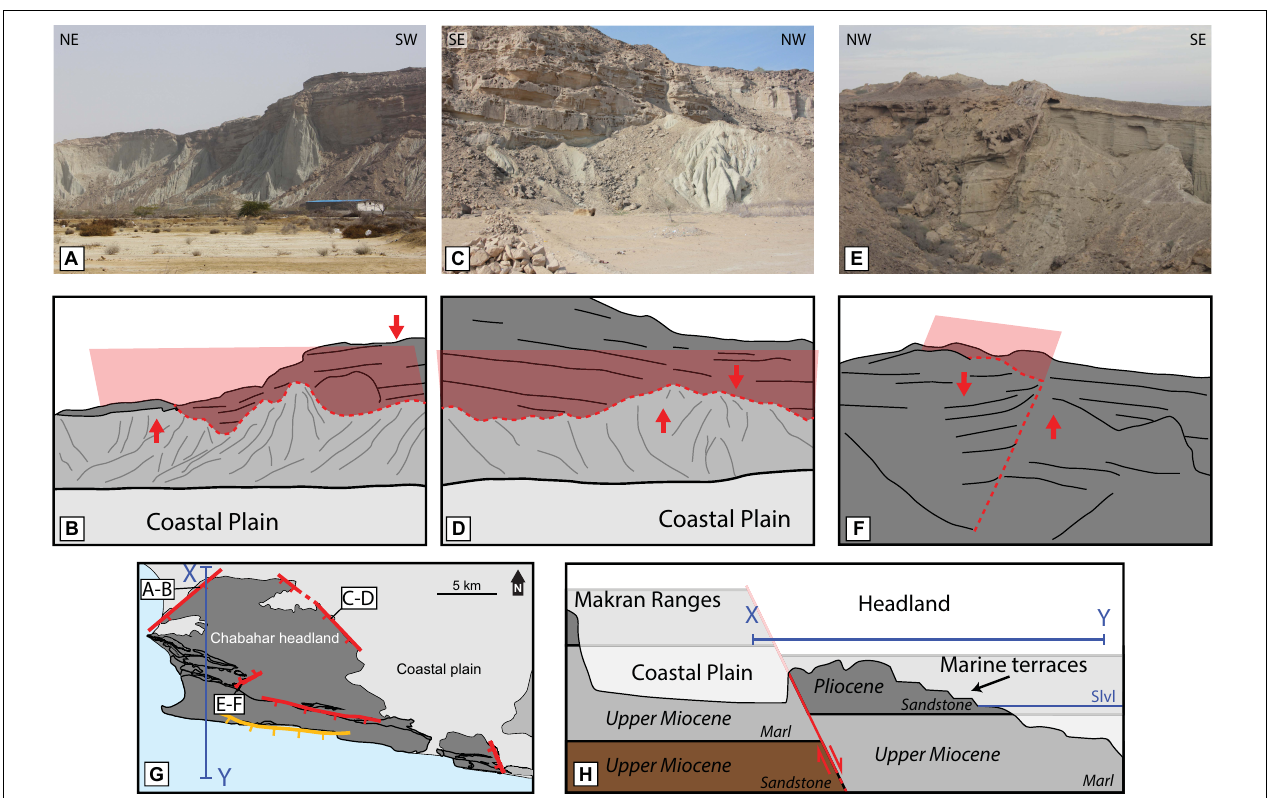
FIGURE 3 | Major normal faults bordering the Chabahar headland. (A–D) Photo and sketch of the outcropping faults. The low-lying coastal plain sits in the uplifted block, whereas the headland is downthrown. (E,F) A major normal fault outcropping within the headland. (G) Localization of the major normal faults of Chabahar headland (red). Orange fault is inferred. (H) Sketch of a profile from the Makran ranges to the sea, going through a downfaulted headland (as in profile X-Y in panel G ). Tectonic deformation of the Tertiary layers is ignored for